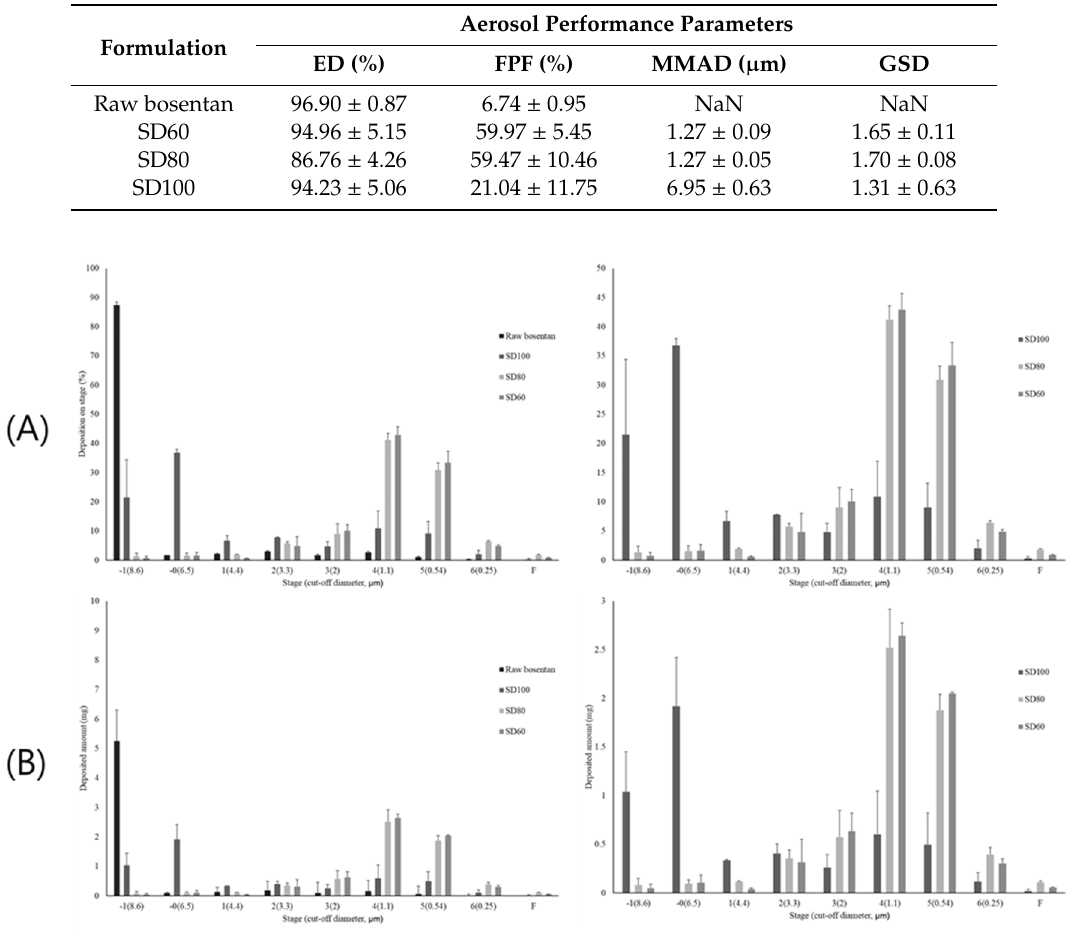
Figure 9. Aerosol performance in each stage of ACI for raw BST and spray-dried BST microparticles (mean ± standard deviation, n = 3): ( A ) deposited percentage; and ( B ) deposited amount (mg). Table 4. Aerosol performance parameters of raw BST and spray-dried BST microparticles (mean ± standard deviation, n = 3).